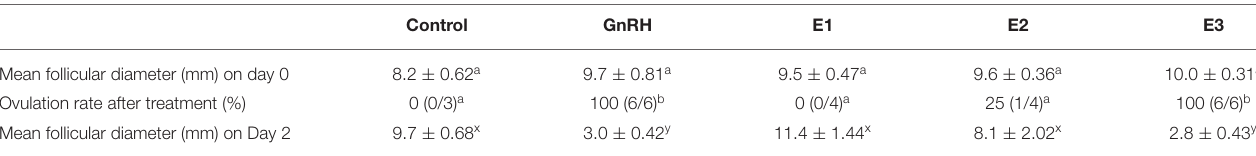
Values with different superscripts within a row are significantly different. a vs. b = Proportions with different superscripts are different (P = 0.0001). x vs. y = differences in mean follicular diameter on Day 2 between groups (P = 0.0001).